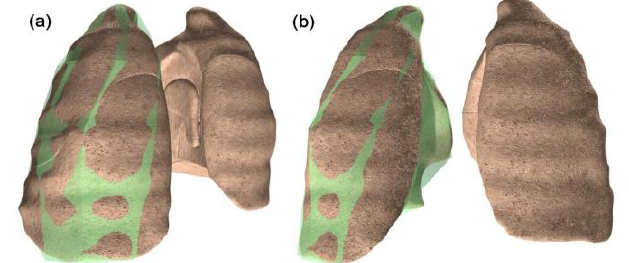
Fig. 5. 3D model of the lungs, along with green approximated geometry used in the collision detection system. Side view in (a) and frontal view in (b).